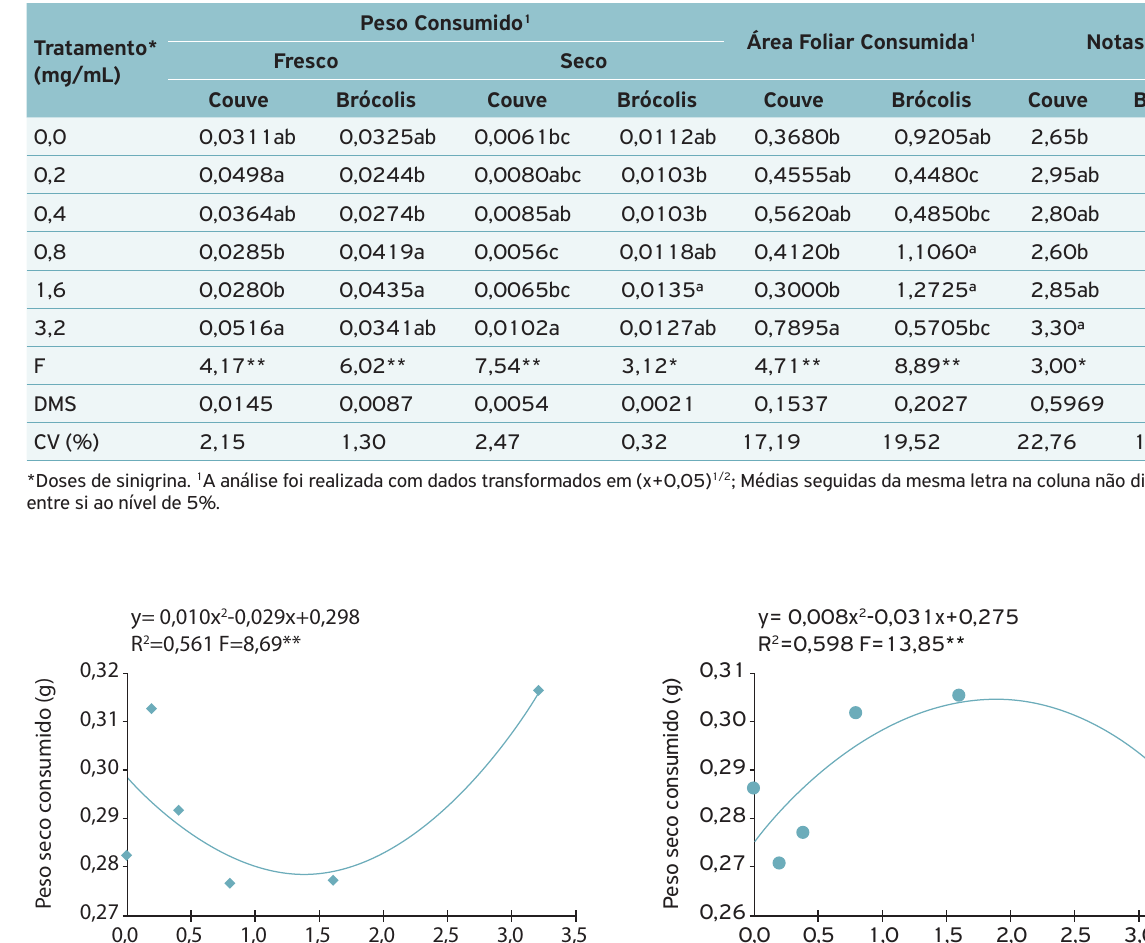
Tabela 2. Peso fresco (g), peso seco (g) e área foliar (cm 2 ) consumidos e notas em função dos danos provocados por lagartas de Plutella xylostella nas diferentes doses de sinigrina (mg/mL).